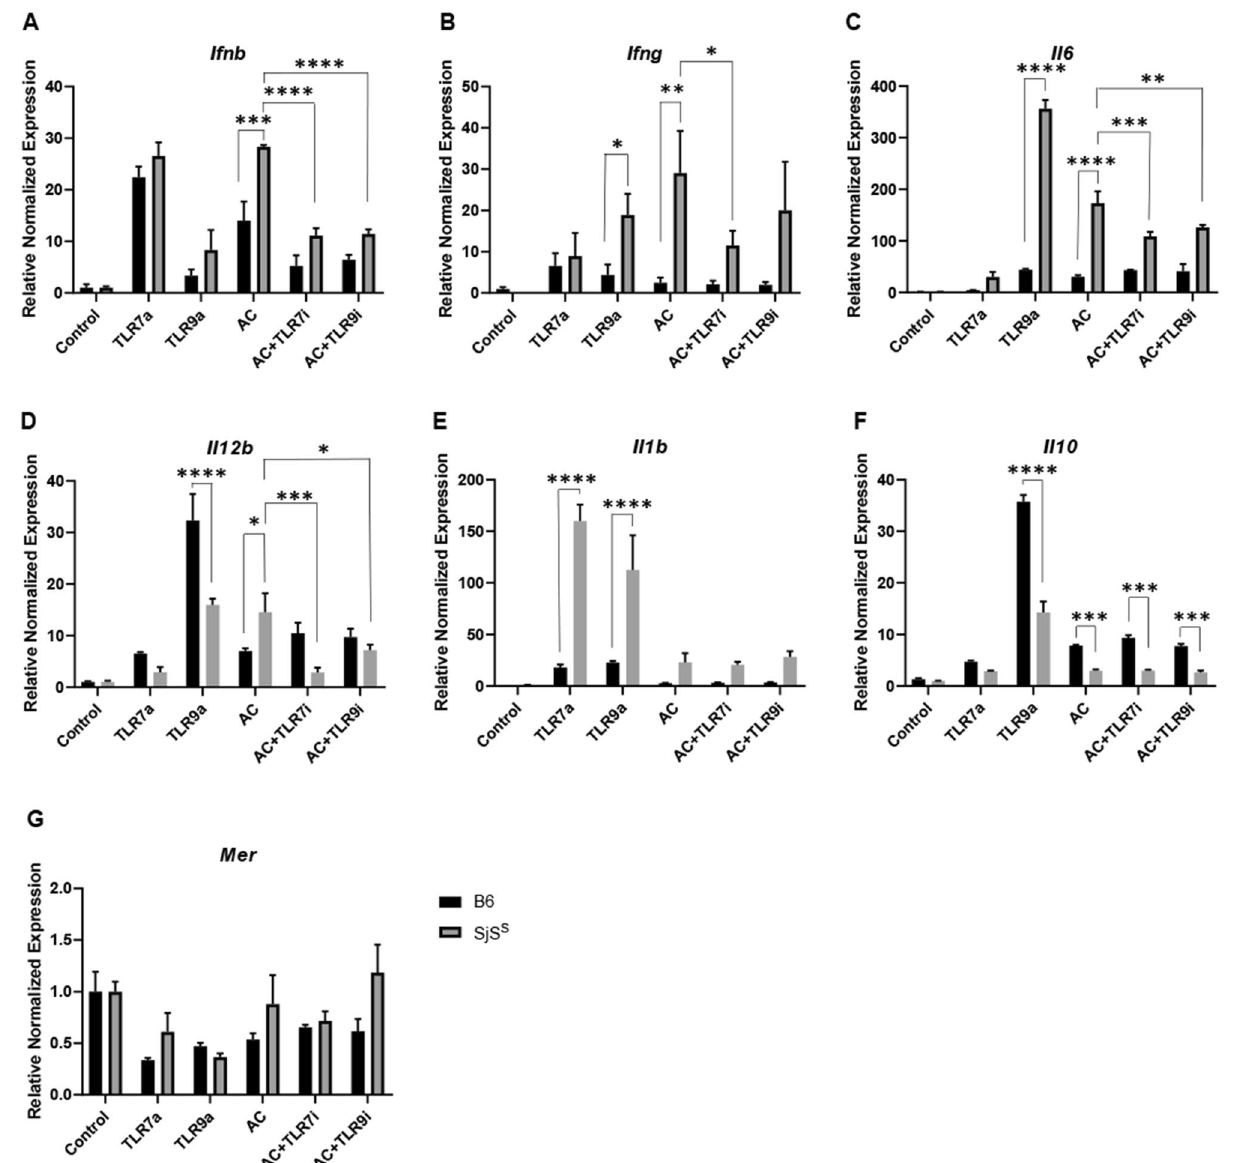
stimulate inflammation, AC, or AC plus TLR7i (ODN 20958), or AC plus TLR9i (ODN 4084-F) to inhibit TLR7 and 9 driven inflammation. All conditions were performed in triplicate. Upon conclusion of treatment, cells were washed, incubated for an additional three hours, and RNA was collected for RT qPCR. The statistical significance was calculated by one-way ANOVA where error bars indicate SEM * p < 0.05, ** p < 0.01, *** p < 0.001, and **** p <